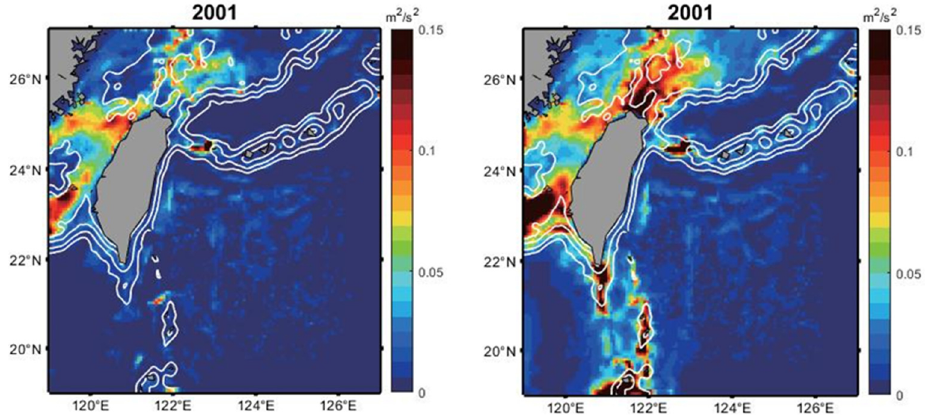
Figure 9. Bottom layer kinetic energy divided by the water density (u 2 + v 2 )/2 in m 2 s − 2 , averaged from the entire time of the simulation. The left ( right ) panel shows the result of simulation without (with) tidal forcing as inputs. Shown as well are 50, 100, 200, 500, and 1000 m isobaths.